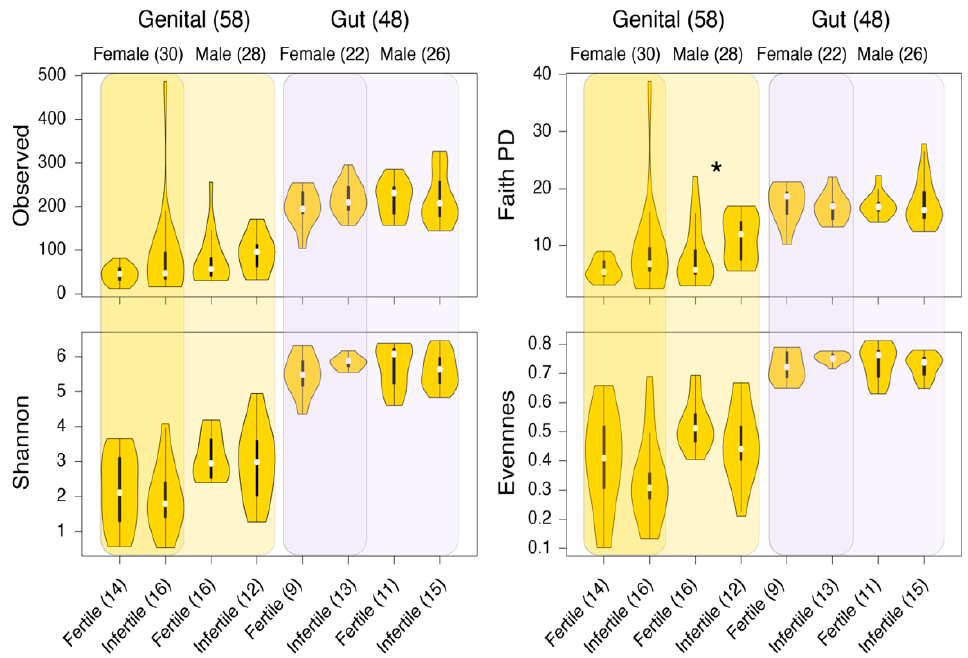
Figure 2. Comparisons of alpha-diversity distributions between the genital and gut samples. Plots are stratified by gender and fertility status. Numbers in parenthesis indicate the total number of samples in that group. * p < 0.05, KW test.